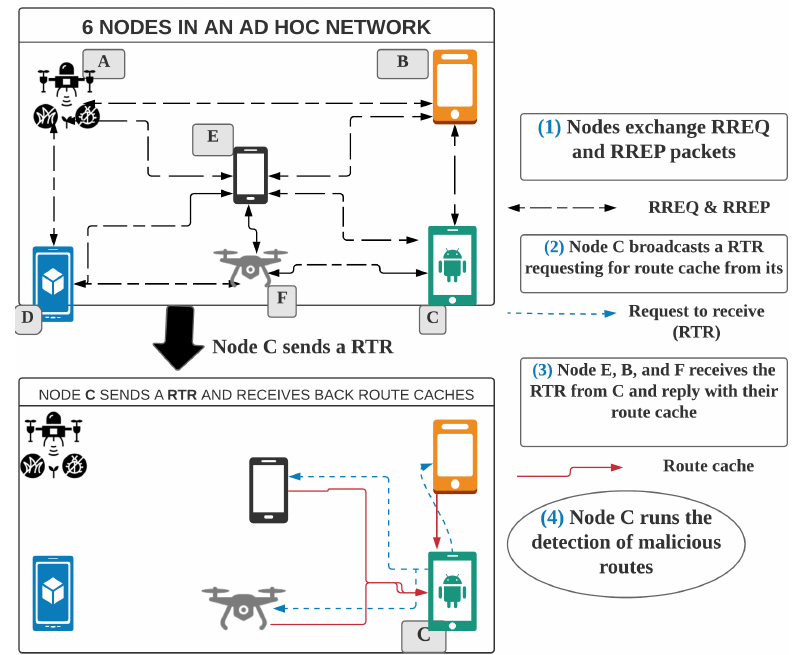
Figure 3. Cooperative host-based detection. RREQ—route request, RREP—route reply.